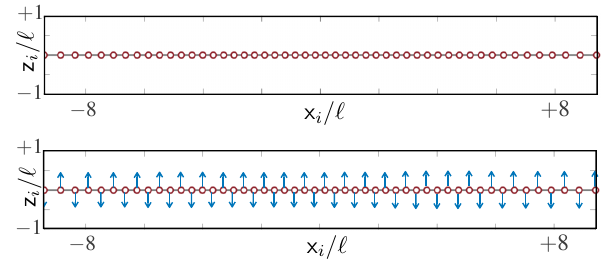
FIG. 4. Trapped-ion chain and effective Ising couplings: (a) equilibrium positions for a chain of N = 50 171 Yb + ions con- fined in a Paul trap with secular frequencies ω x / 2 π = 0.1 MHz, and ω z / 2 π = 3.75 MHz. The microscopic length scale corre- sponds to (cid:23) = 12.7 μ m in this case, while the minimum distance at the bulk of the ion chain is a = 4.4 μ m. (b) The blue alternat- ing arrows depict the lowest vibrational mode in the transverse branch, the zigzag